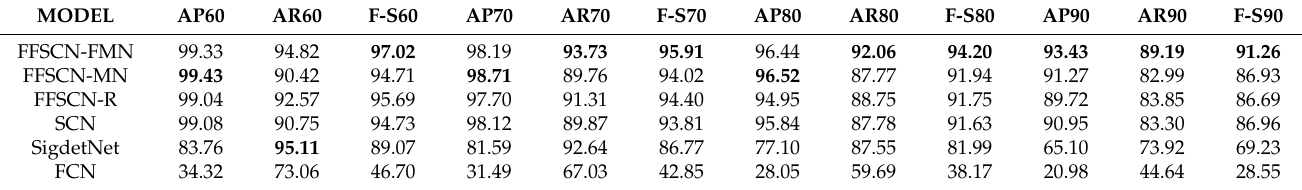
Table 3. Performance comparison of the proposed FFSCN and other deep-learning-based methods on the whole validation dataset.